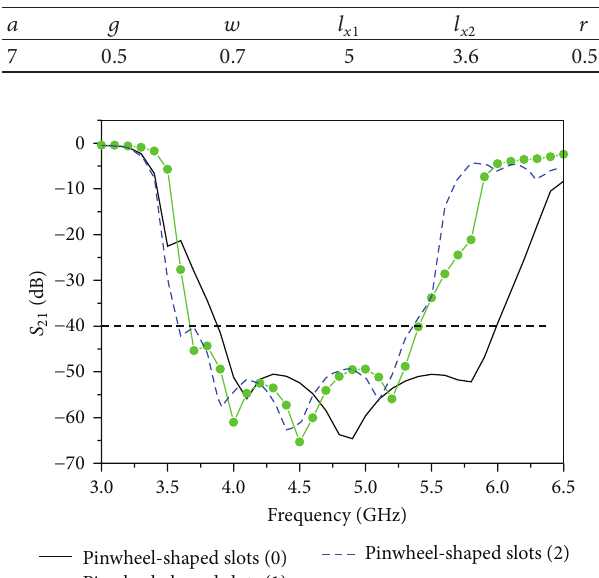
Table 2: Parameters of the high impedance EBG unit structure (unit: mm).